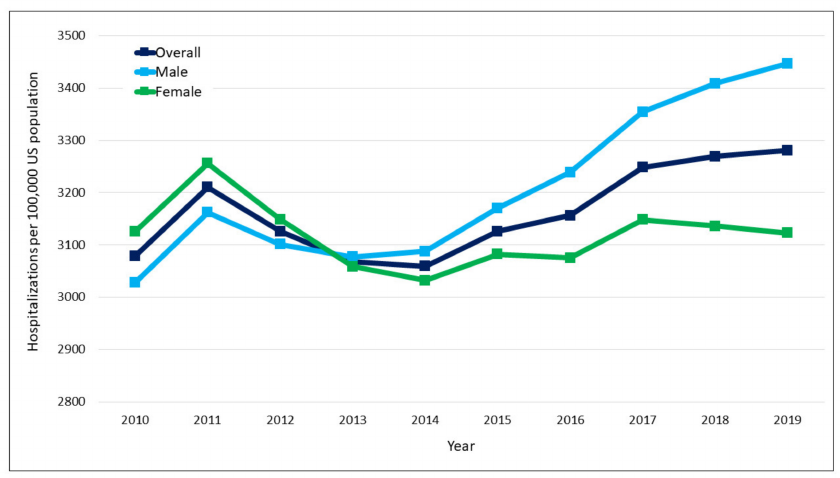
Figure 1. Trends in overall and gender-specific population-adjusted diabetes associated hospitalizations.